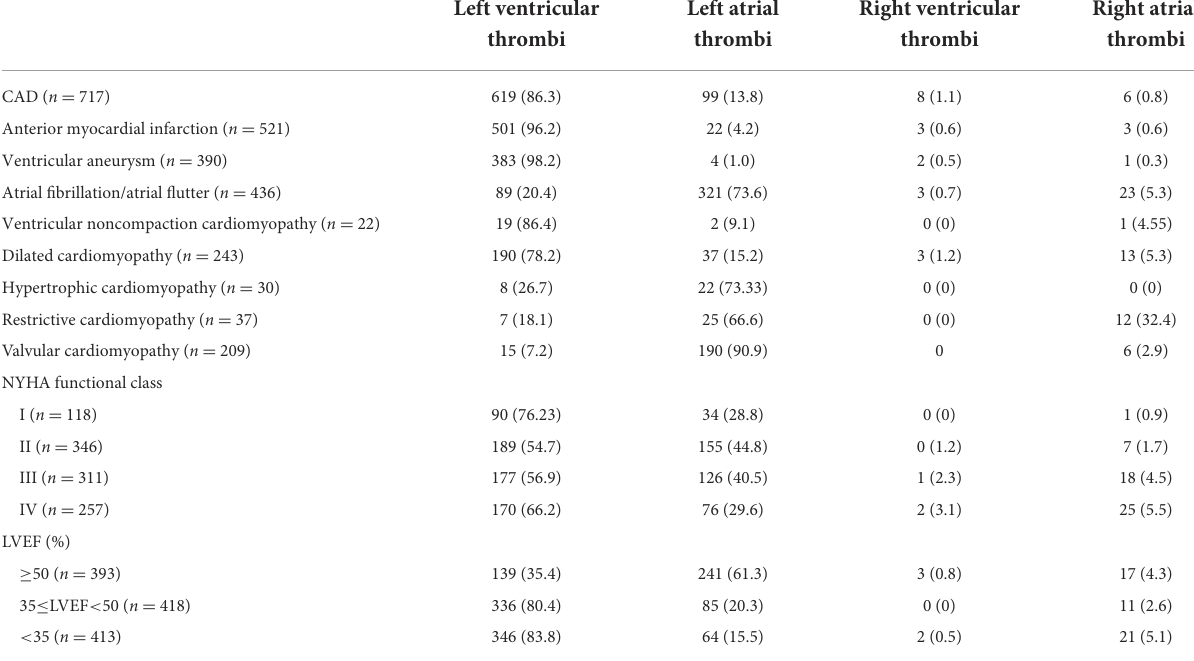
Left ventricular thrombi